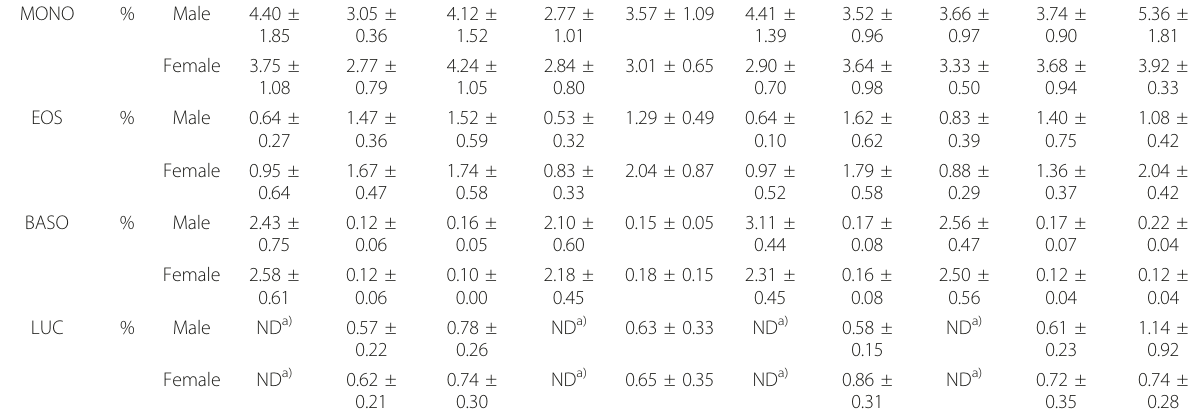
Table 3 Hematological values in rats orally treated with PM012 (Continued)